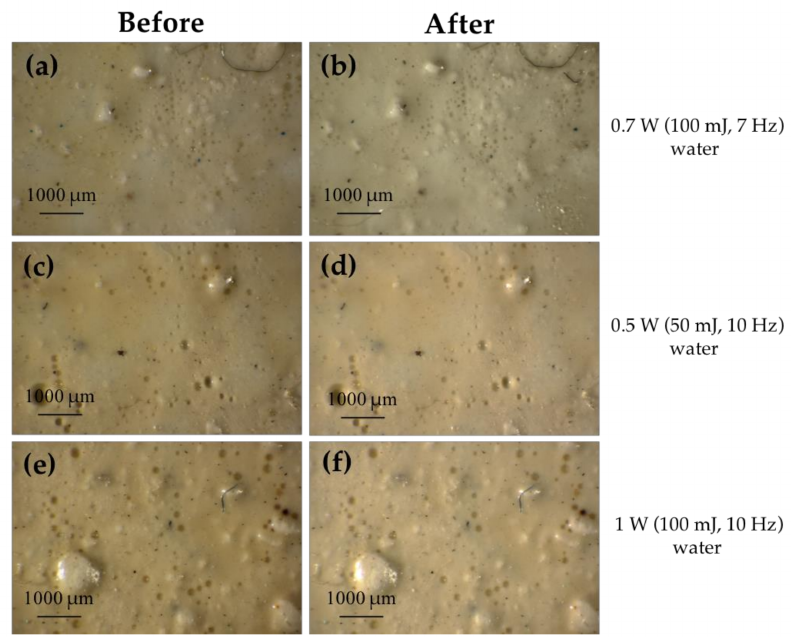
Figure 4. The microscopic images (32 × ) of mastic removal by Er:YAG laser under varied conditions and water as wetting agent, conducted on lead white tempera mock-ups. ( a , c , e ) was taken before cleaning, while ( b , d , f ) was obtained after cleaning in wet (H 2 O) conditions with varied laser power (0.7 W, 0.5 W and 1 W